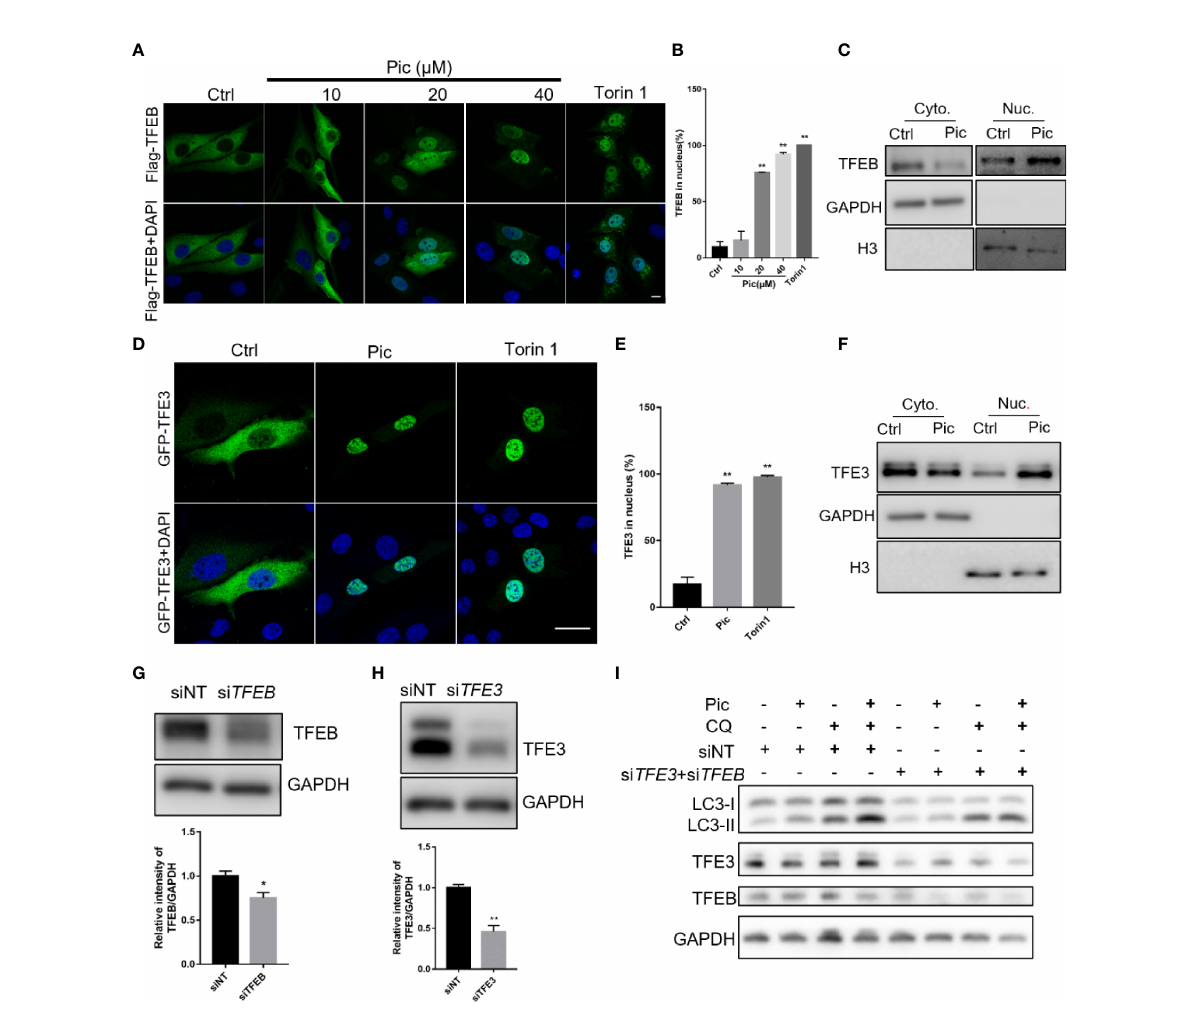
FIGURE 2 Piceatannol promotes autophagy fl ux via TFEB/TFE3. (A, B) Pic promotes the nuclear accumulation of TFEB. U2OS cells expressing Flag-TFEB were treated with indicated concentrations of Pic for 24 h before visualization of the nuclear accumulation of TFEB by immunostaining (A) , and the percentage of cells containing nuclear TFEB was quanti fi ed in (B) . Scale bar: 10 µm. (C) Pic-promoted nuclear accumulation of TFEB was further con fi rmed by western blotting in the cytoplasm and the nuclear fractions after treating cells with 40 µM Pic for 24 h. (D, E) Pic promotes the nuclear accumulation of TFE3. The nucleus accumulation of TFE3 was detected by immunostaining (D) and quanti fi ed (E) in U2OS cells expressing EGFP-TFE3 after incubating cells with 40 µM Pic for 24 h. Scale bar: 10 µm. (F) Western blotting analysis of the nuclear accumulation of TFE3 in the cytoplasm and the nuclear fractions from Pic (40 µM)-treated cells. (G – I) Knocked down the expression of TFEB (G) and TFE3 (H) inhibits Pic-induced autophagy fl ux (I) . Error bars indicate SEM for at least three biological replicates. Student-t test was used for statistical analysis. * p -value < 0.05 and ** p -value <